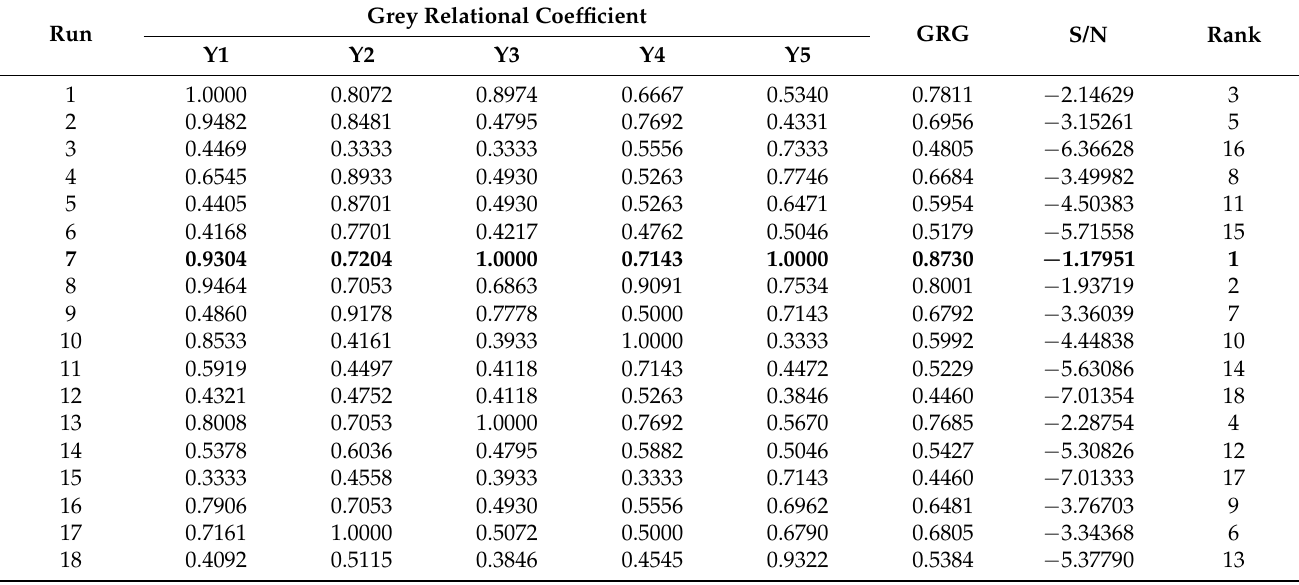
Table 8. Grey relational coefficient, grey relational grade (GRG) and S/N conversion of GRG for different operational parameters combinations during the flocculation of the Bacillus sp. BioSol021 cultivation broth and antimicrobial activity testing against the selected phytopathogens.